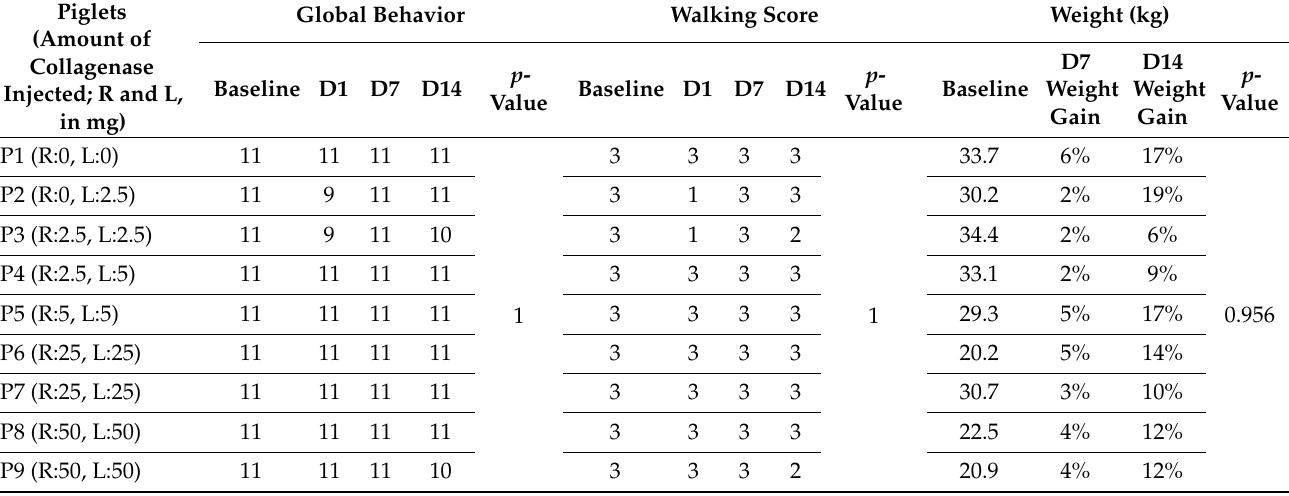
Table 3. Clinical follow up evaluating the global behavior with a 11-point scale, a focus on